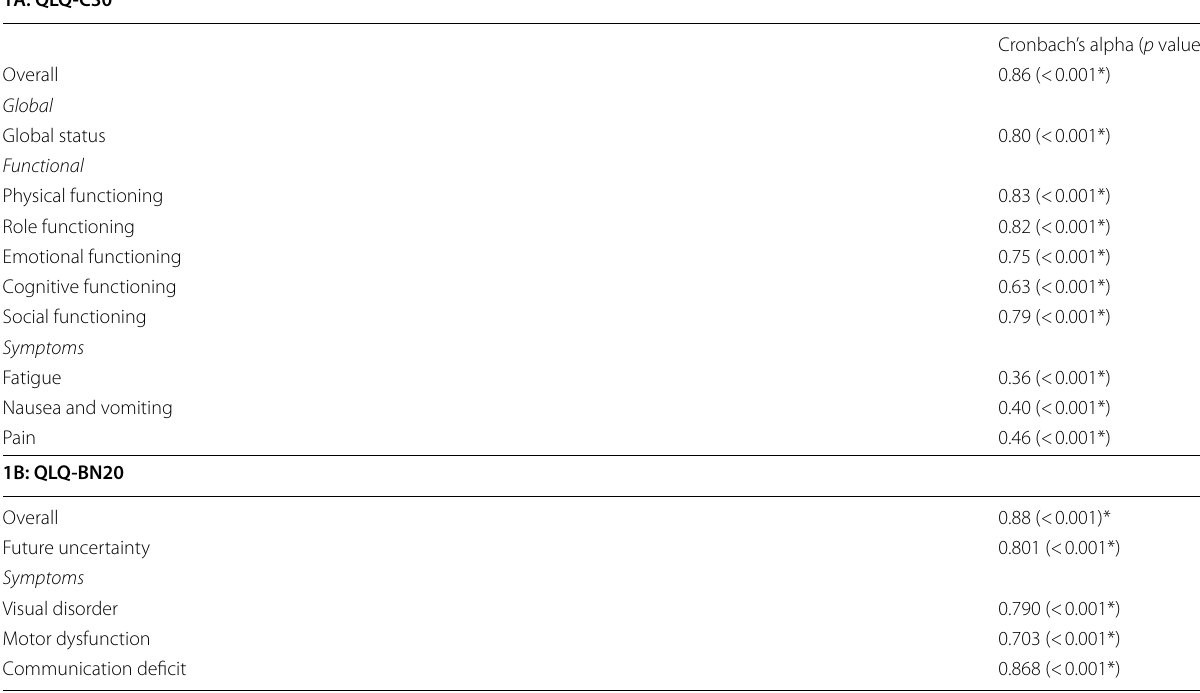
*Significant at p -value < 0.05 by reliability